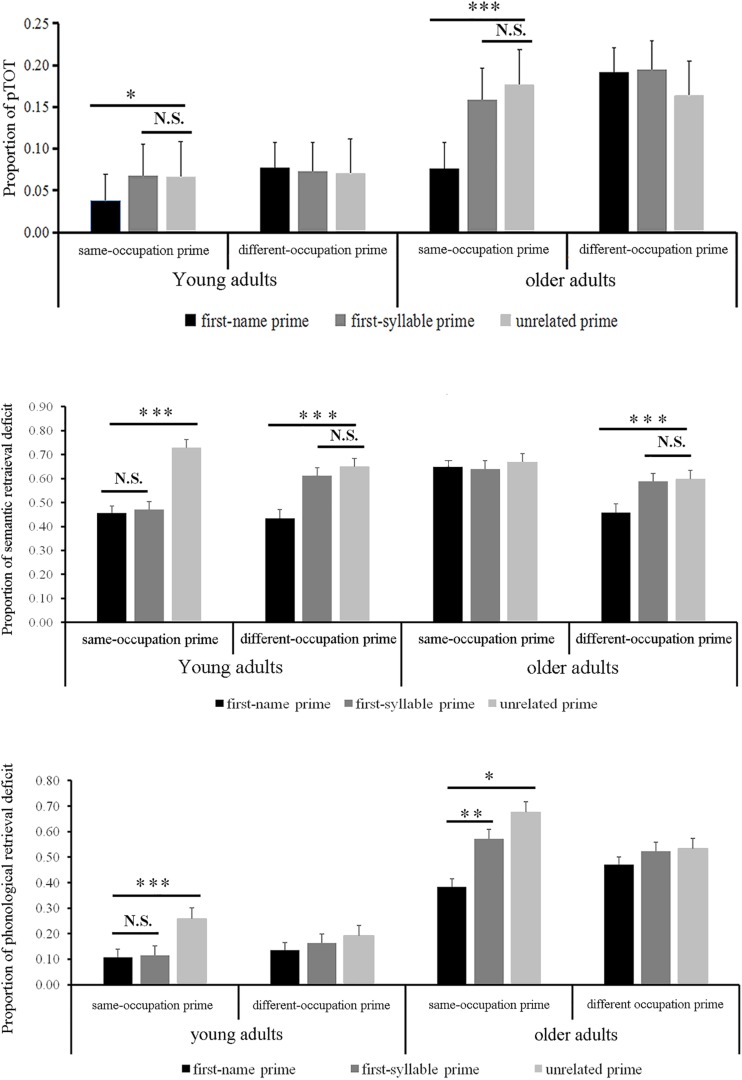
Proportions of pTOT (upper panel), semantic retrieval deficit (middle panel), and phonological retrieval deficit (lower panel) as a function of semantic relatedness and phonological relatedness in young and older adults in Experiment 2. Vertical bars correspond to standard errors. Asterisks indicate significance of the difference (∗p < 0.05; ∗∗p < 0.01; ∗∗∗p < 0.001; and N.S., p > 0.05).